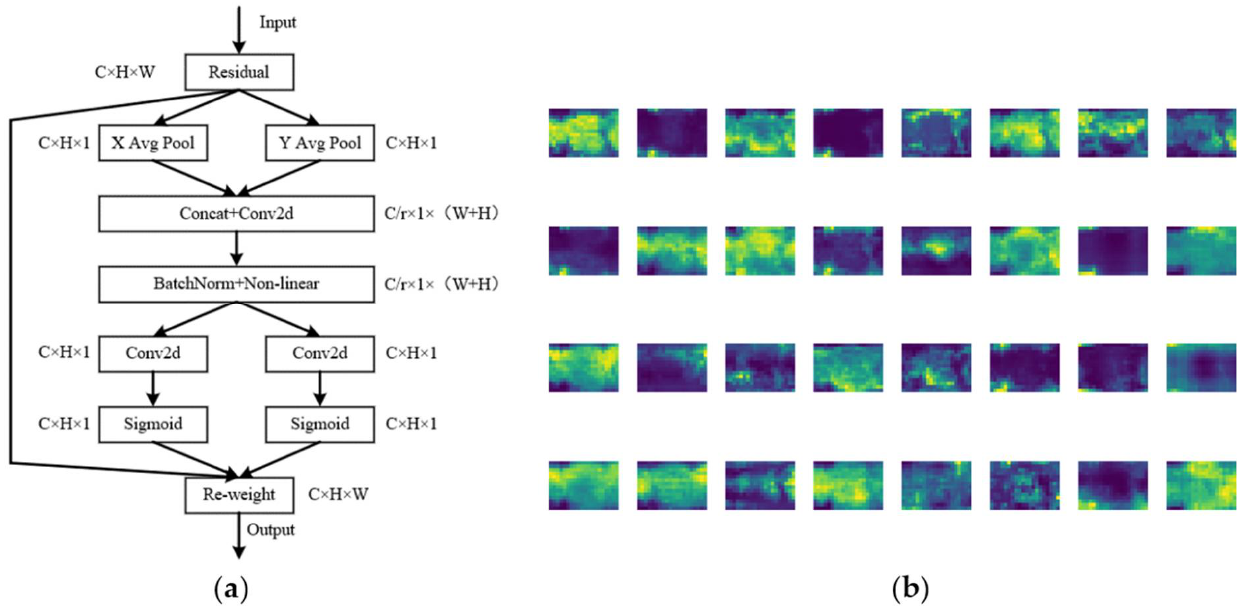
Figure 5. Coordinated attention mechanism. ( a ) Network structure. ( b ) Feature map output from the coordinated attention mechanism.